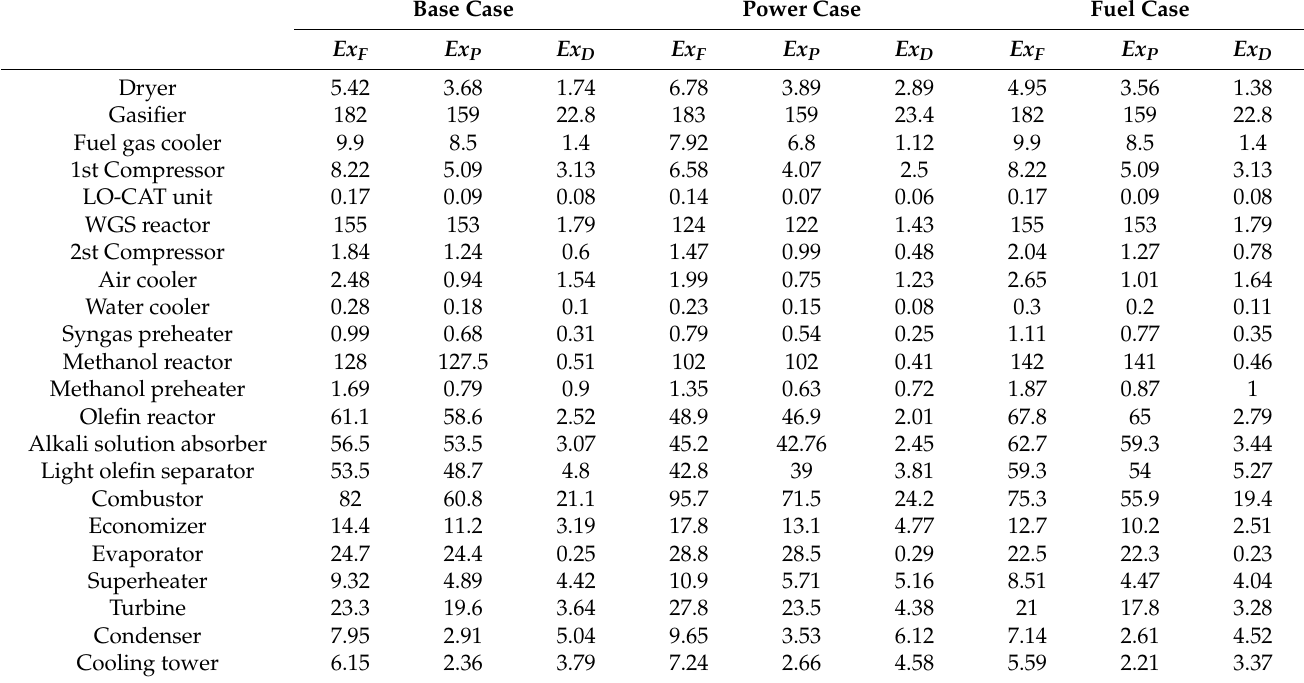
Table 6. Exergy balance at the level for each case.